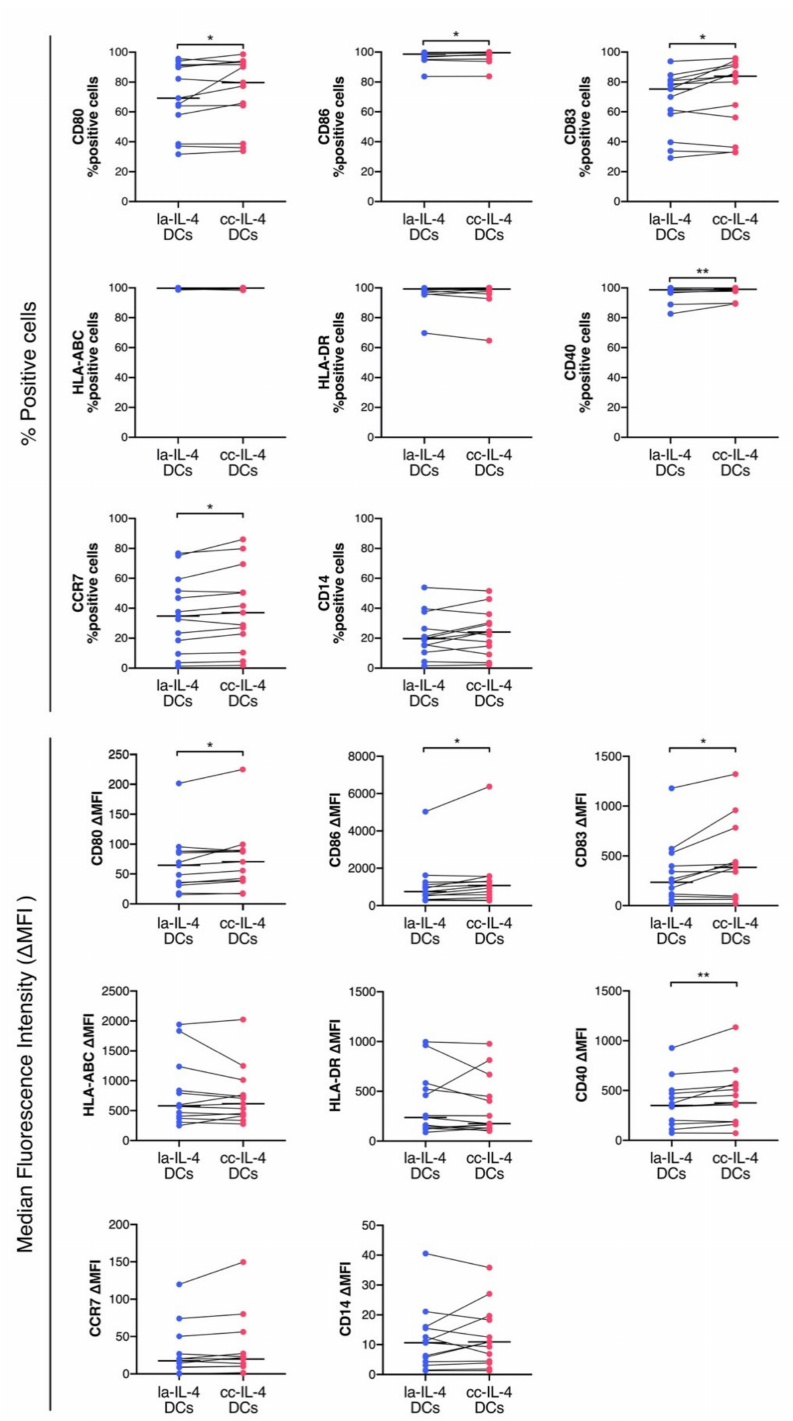
Figure 3. Comparison of low − adherent − IL-4 − DCs (la − IL-4 − DCs) and cluster − controlled IL- 4 − DC (cc − IL-4 − DCs) phenotypes. After harvesting la − IL-4 − DCs and cc − IL-4 − DCs prepared from the same donors, DCs were stained with antibodies for DC markers and analyzed by flow cytometry. The results are shown as the median percentage of positive cells and ∆ MFI. The ∆ median fluorescence intensity ( ∆ MFI) was calculated by subtracting the isotype control MFI values from observed values. * p < 0.05, ** p < 0.01 indicate a statistically significant difference compared to cc − IL-4 − DCs ( n = 13). The horizontal bars in graphs represent the median of each